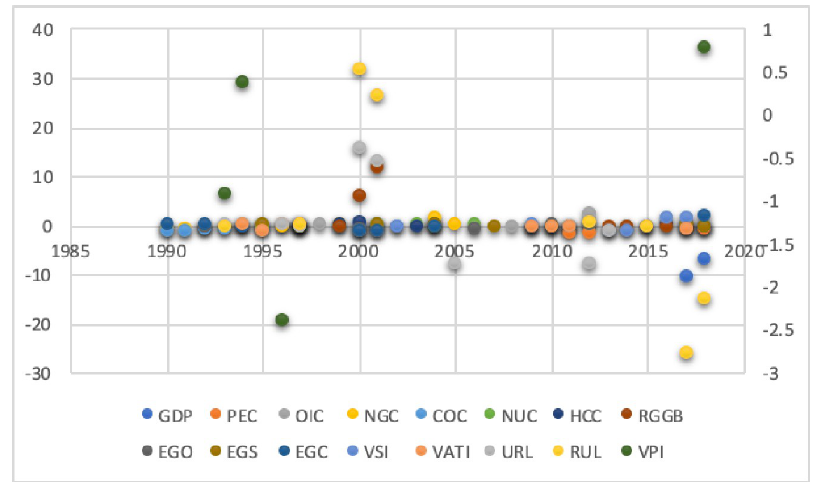
Fig 5. Strong positive and negative decoupling.